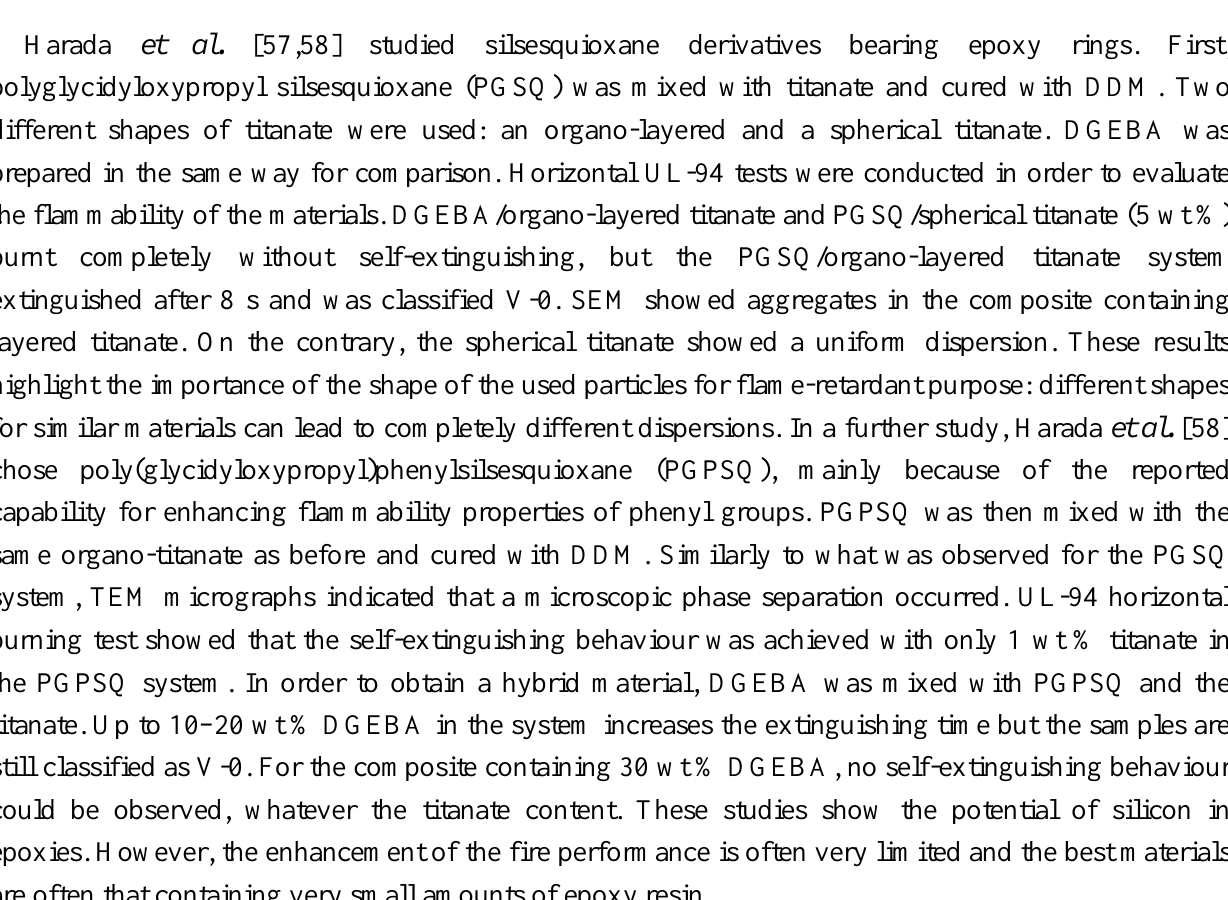
Figure 8. Spiroorthoester containing